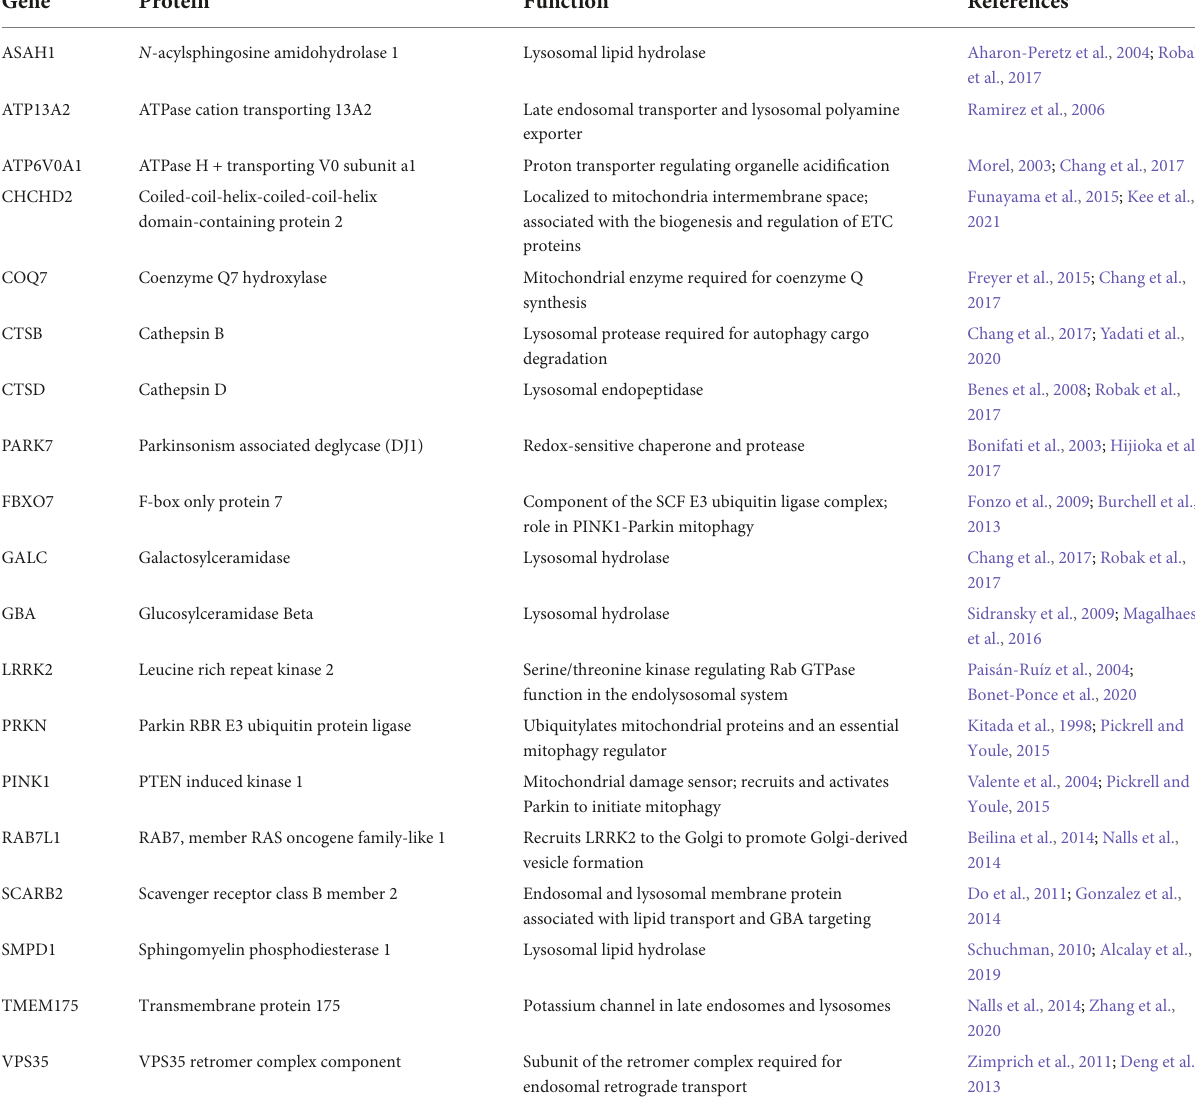
TABLE 1 Mitochondrial and endolysosomal associated genes linked to Parkinson’s